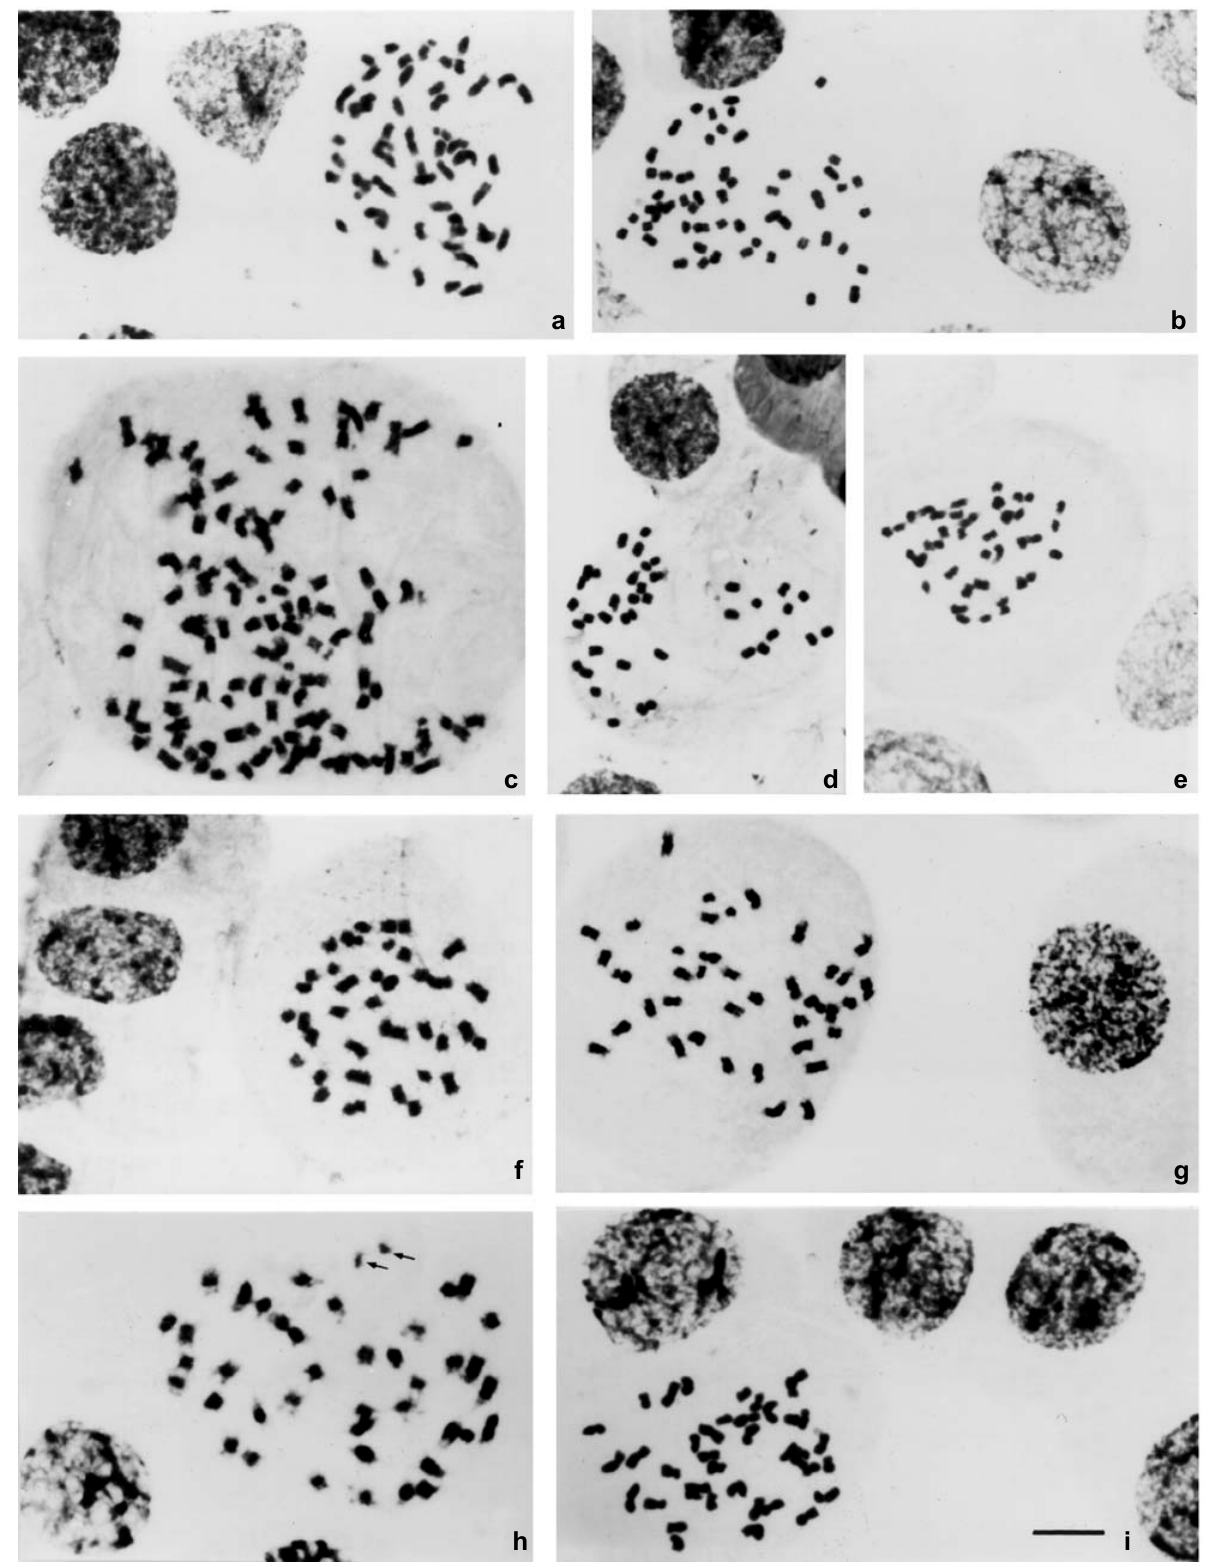
Figure 2 - Chromosome complements and interphase nuclei of orchid species of the subtribes Catasetinae, Maxillariinae, Stanhopeinae and Lycastinae. ( a ) Catasetum macrocarpum (2n = 54); ( b ) C. purum (2n = 54); ( c ) C. discolor (2n = ca. 108); ( d ) Maxillaria rufescens (2n = 40); ( e ) Trigonidium a cuminatum (2n = 40); ( f ) T. obtusum (2n = 40); ( g ) Gongora quinquenervis (2n = 40); ( h ) Coryanthes speciosa (2n = 40) (arrows indicate detached satellites), and ( i ) Xylobium foveatum (2n = 40). Bar represents 10 µ